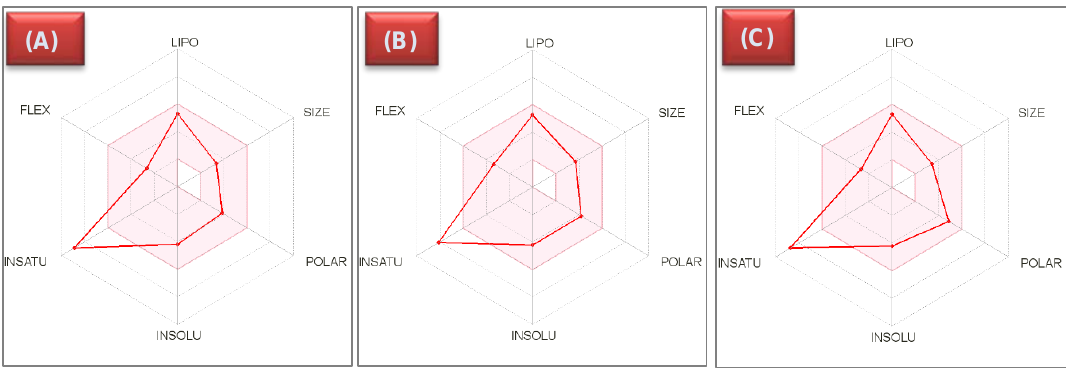
Figure 9. Boiled egg chart, generated from SwissADME online web tool, showing the high oral absorption of benzimidazole derivatives, 10d – f , and the probability of compound 10d only to penetrate the BBB.